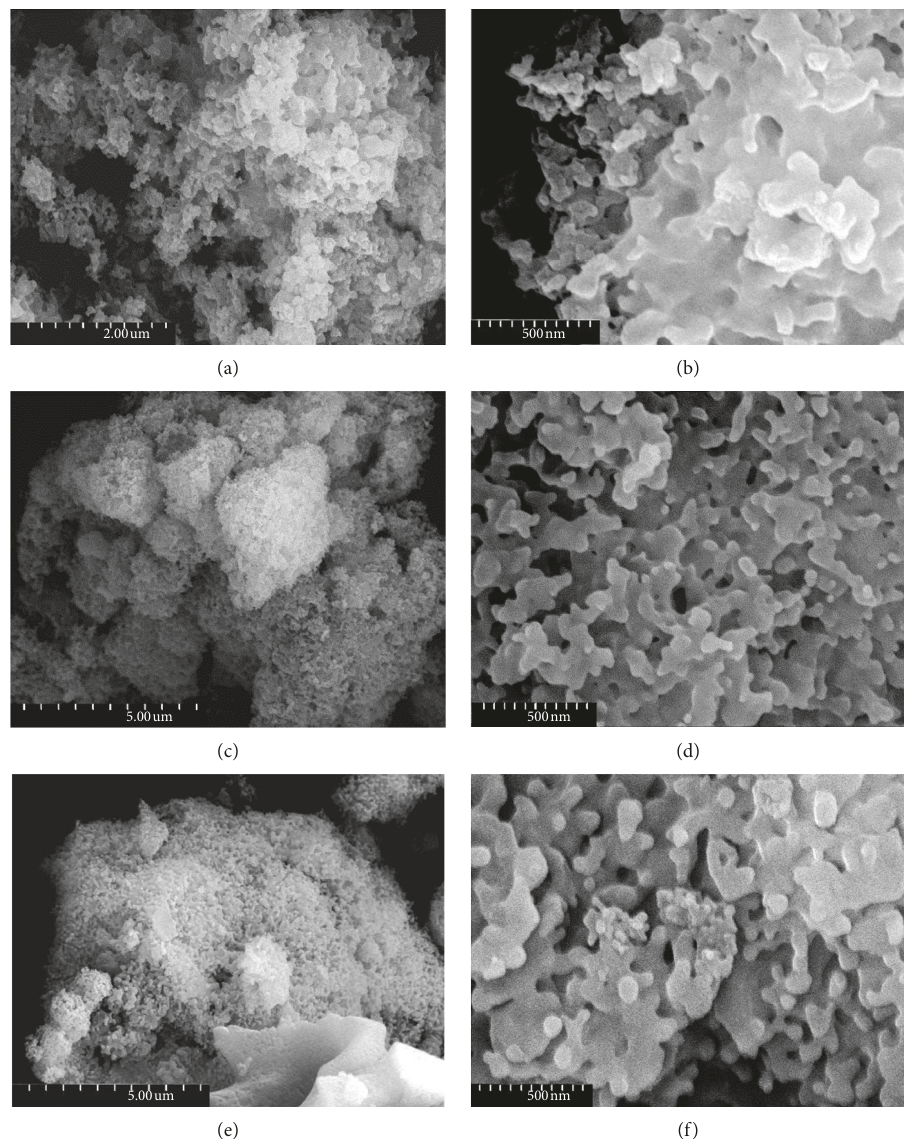
Figure 5: FESEM micrograph of the synthesized powders: (a, b) n � 1, (c, d) n � 2, and (e, f) n �